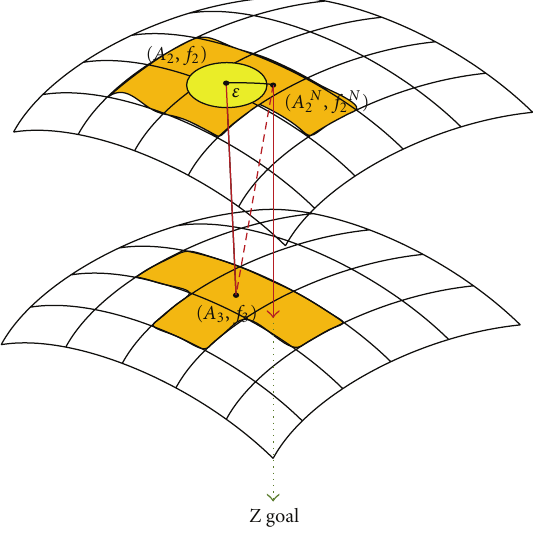
Figure 9: Transition problems between states inside Search Strat- egy.